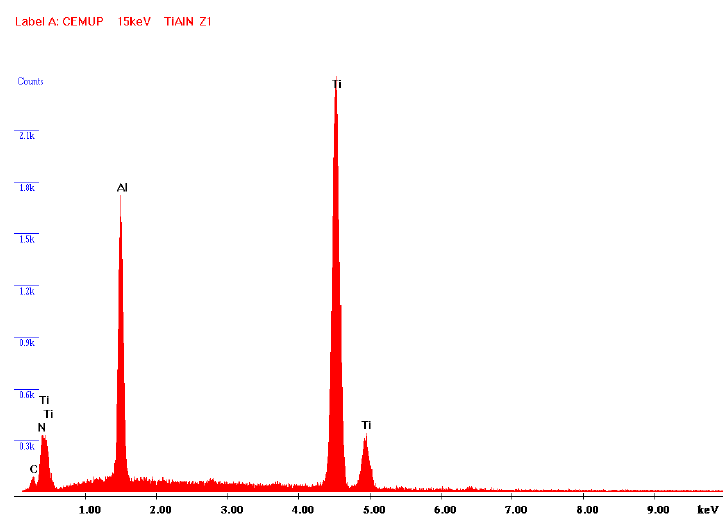
Figure 5. SEM micrograph of TiAlN film cross section with corresponding thickness measurements.